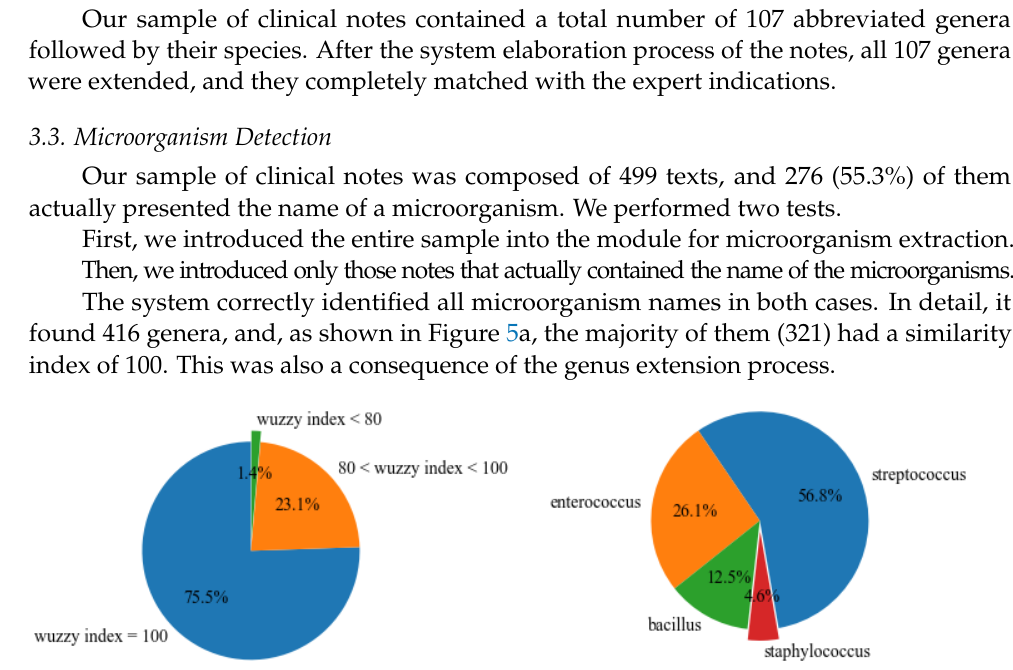
Figure 4. Mean accuracy performances of the three classifiers displayed for each value of the total number of features. Each data point is the mean value of 20 values obtained by shuffling the data.